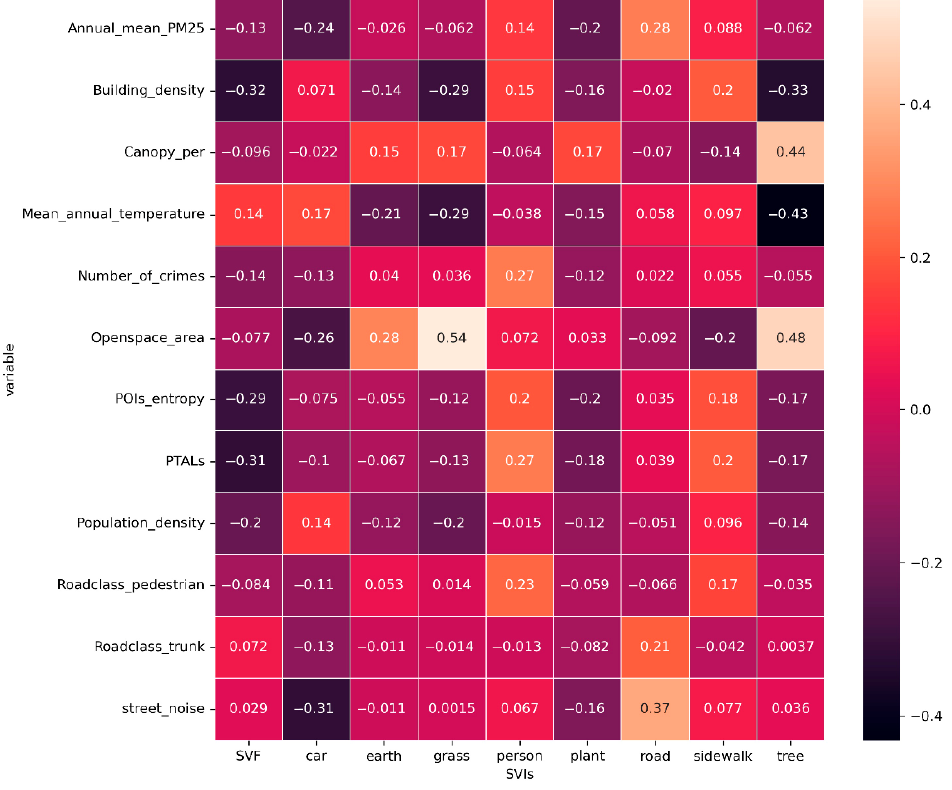
Figure 7. The pairwise correlation matrix analysis between macro-scale variables and micro-scale variables (only pairs of variables with correlation coefficients greater than 0.2 were visualized). Table 3. The ordinary least squares (OLS) in a 100 m buffer zone of 40,290 sample points.